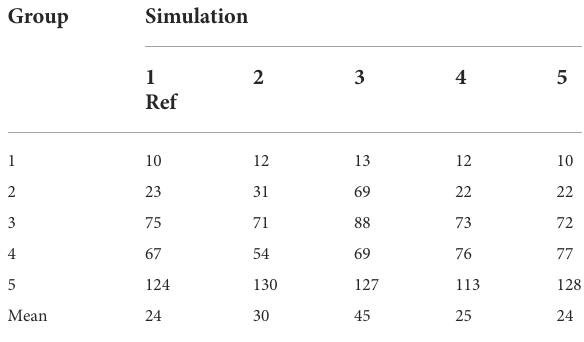
Frontiers in Built